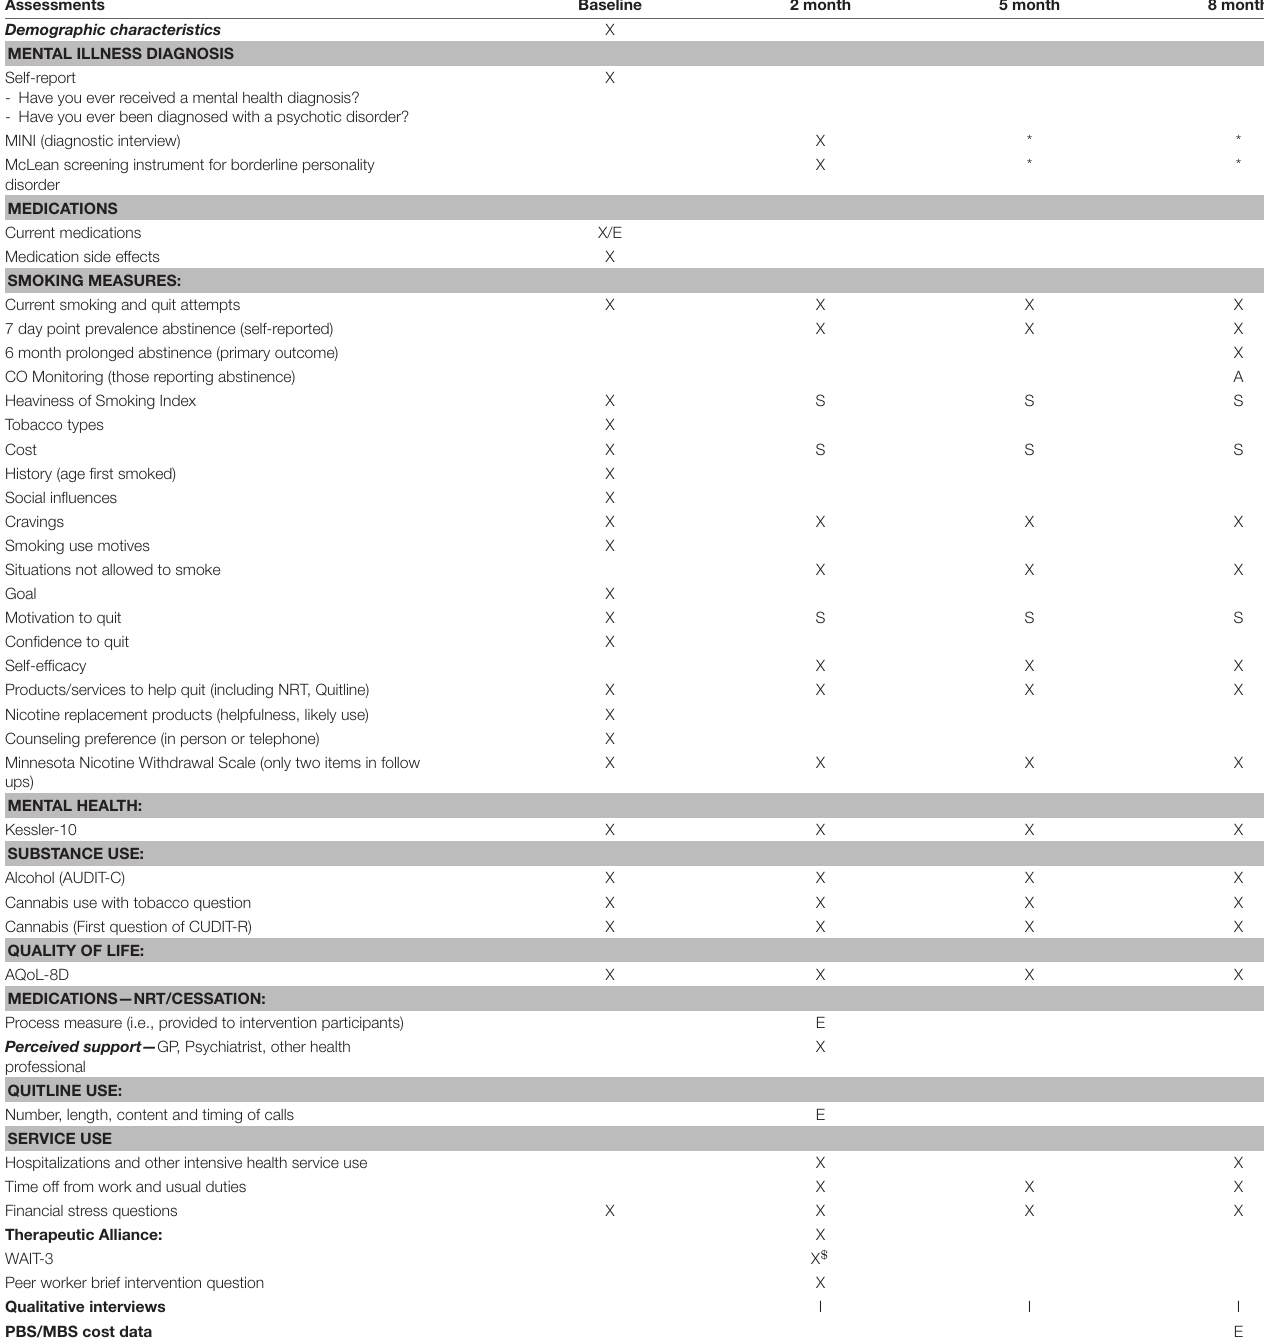
TABLE 1 | Assessment